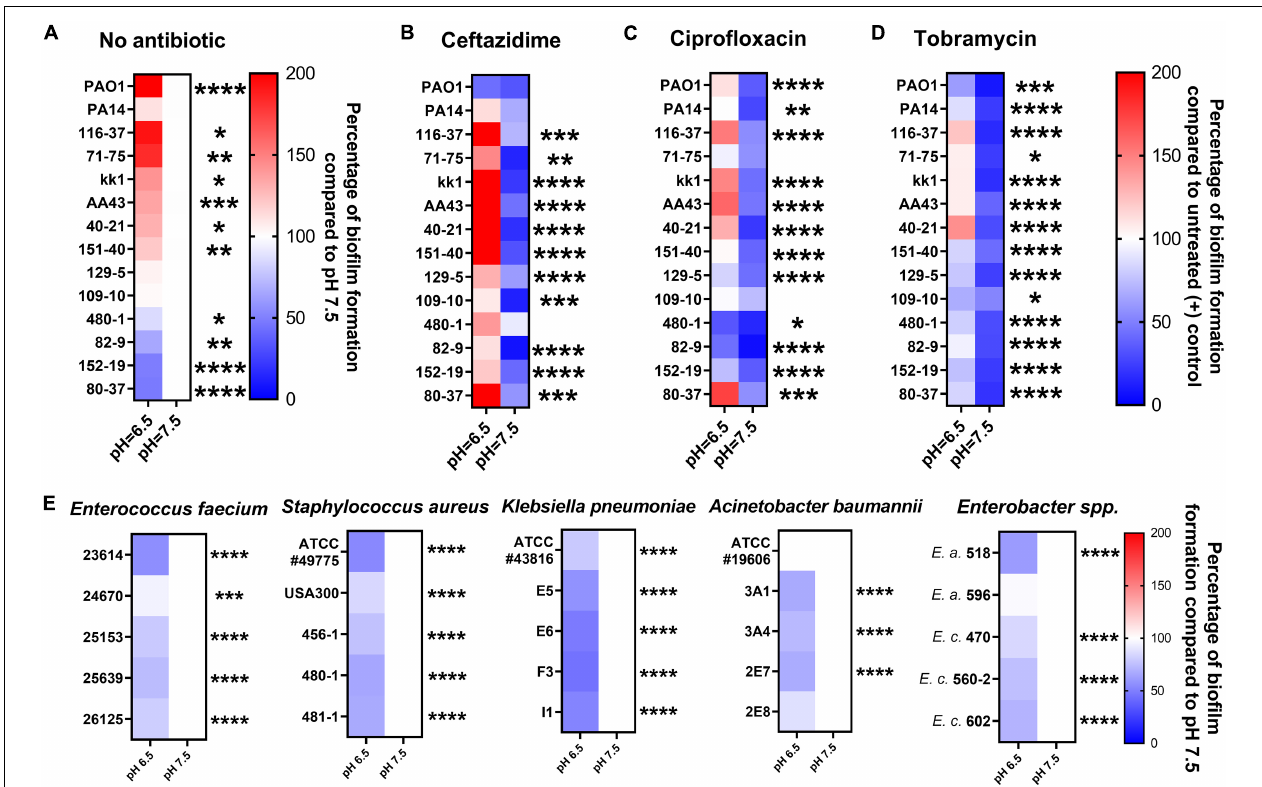
FIGURE 3 | Acidic pH modulates ESKAPE pathogens biofilm formation and impairs antibiotic biofilm prevention against P. aeruginosa. All P. aeruginosa strains (2 lab strains and 12 clinical strains) were incubated in pH adjusted m63 medium for 18 h. The crystal violet staining method was used to quantify biofilm formation ( n = 6). (A) P. aeruginosa biofilm formation without antibiotic treatment. Biofilm formation in pH 7.5 served as a positive control. (B–D) P. aeruginosa biofilm formation was treated by ceftazidime, ciprofloxacin, and tobramycin at the concentrations of 1x MIC of each P. aeruginosa strain (MIC in normal pH 7.5 condition). The percentage of antibiotic-treated biofilm formation was calculated by comparing it to each untreated P. aeruginosa strain in pH 7.5. (E) Biofilm formation of other bacterial species of the ESKAPE bacterial pathogens. Five isolates from each of the other ESKAPE species were grown at pH 6.5 and 7.5 (as a control) in biofilm mode. E.a. and E.c. are abbreviations for Enterobacter aerogenes and Enterobacter cloacae, respectively. The color scale bars represent the percentage of biofilm formation compared to appropriate control groups. Red scale: increased biofilm formation (100%–200%); white: no change (100%); blue scale: decreased biofilm formation (0–100%). Data were collected from three independent experiments. Unpaired t -test was used for statistical analysis between each pH 6.5 and pH 7.5 conditions. * p < 0.05; ** p < 0.01; *** p < 0.001; **** p < 0.0001; otherwise not